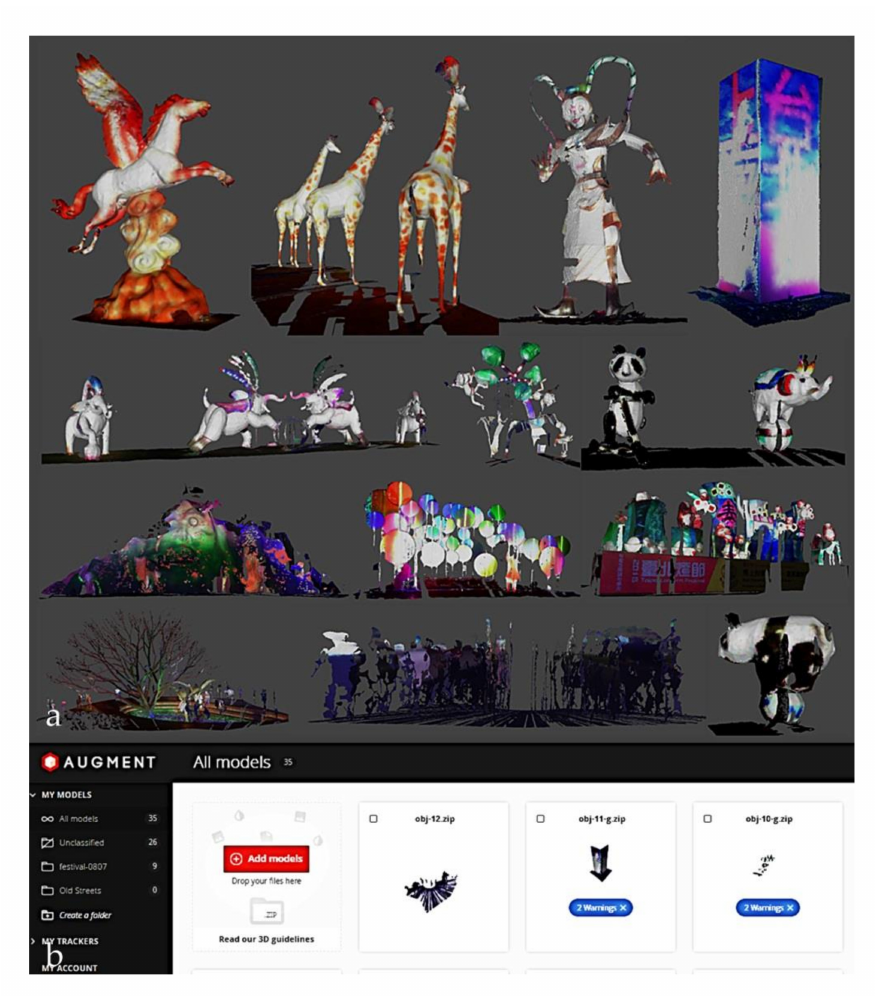
Figure 3. ( a ) Augmented reality (AR) models for situated simulations; ( b ) corresponding representa- tions in the augmented reality (AR) app.